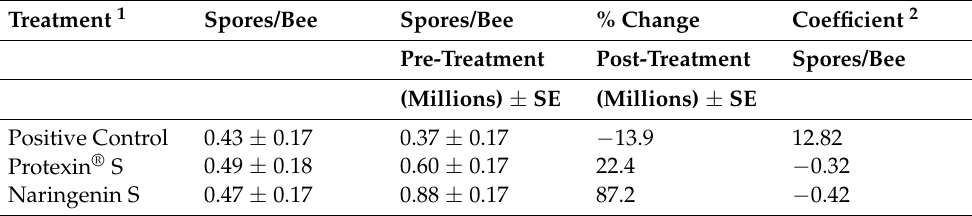
Table 9. Effect of fall 2018 treatments on N. ceranae spore counts per bee one-two days pre-treatment and three weeks post-treatment with the prebiotic naringenin or probiotic Protexin ® . Coefficients indicate how the log of spores per bee changed relative to the positive control. Means are from 100 bees in 33–34 colonies per treatment.